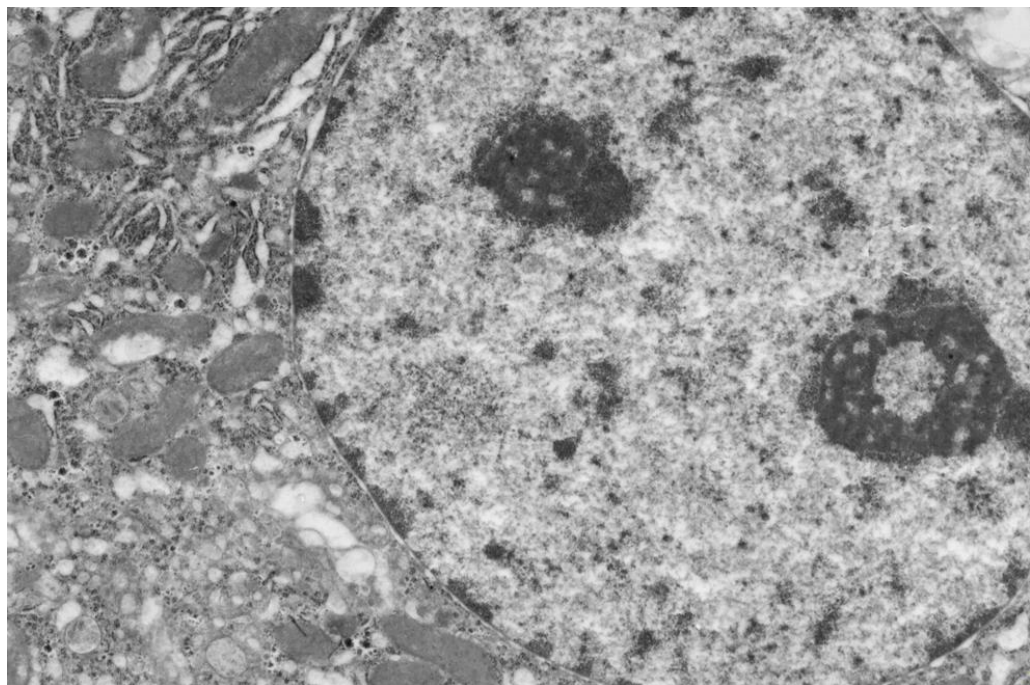
Figure 7. Effect of preliminary administration of mannan B in mice with acute lipemia induced by P-407 (250 mg/kg, 24 h). Fragment of hepatocytes: enlarged cisterns of Golgi complex and granular endoplasmic net; decreased amount of glycogen rosettes. Activation of nucleolar in hepatocyte nucleus. Magnification 6000×.